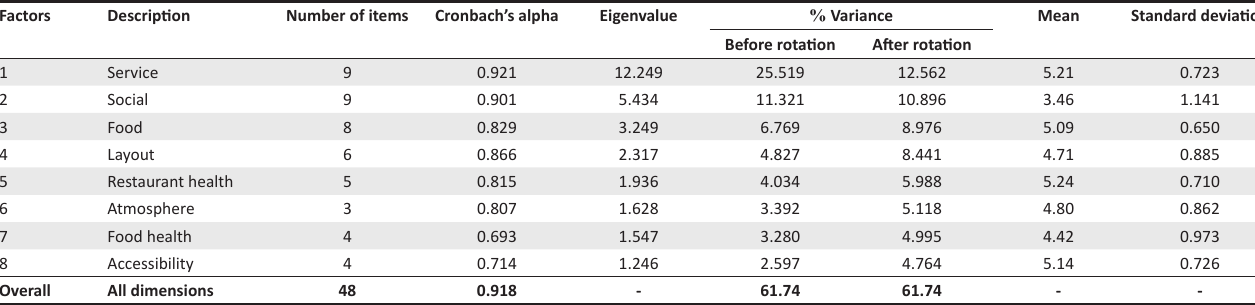
TABLE 3: Reliability statistics for the eight extracted components ( N = 363). Factors Description Number of